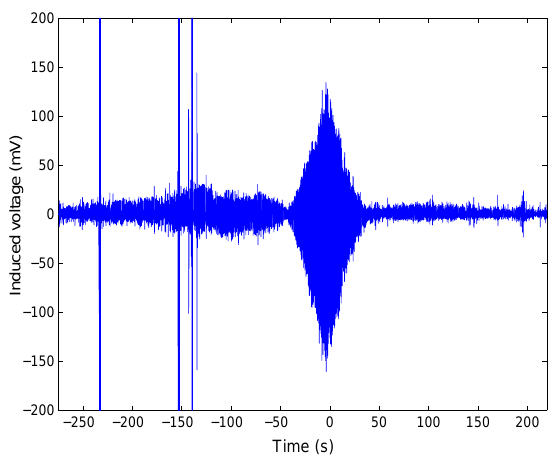
Figure 4. The original voltage signal induced on magnetic sensor.